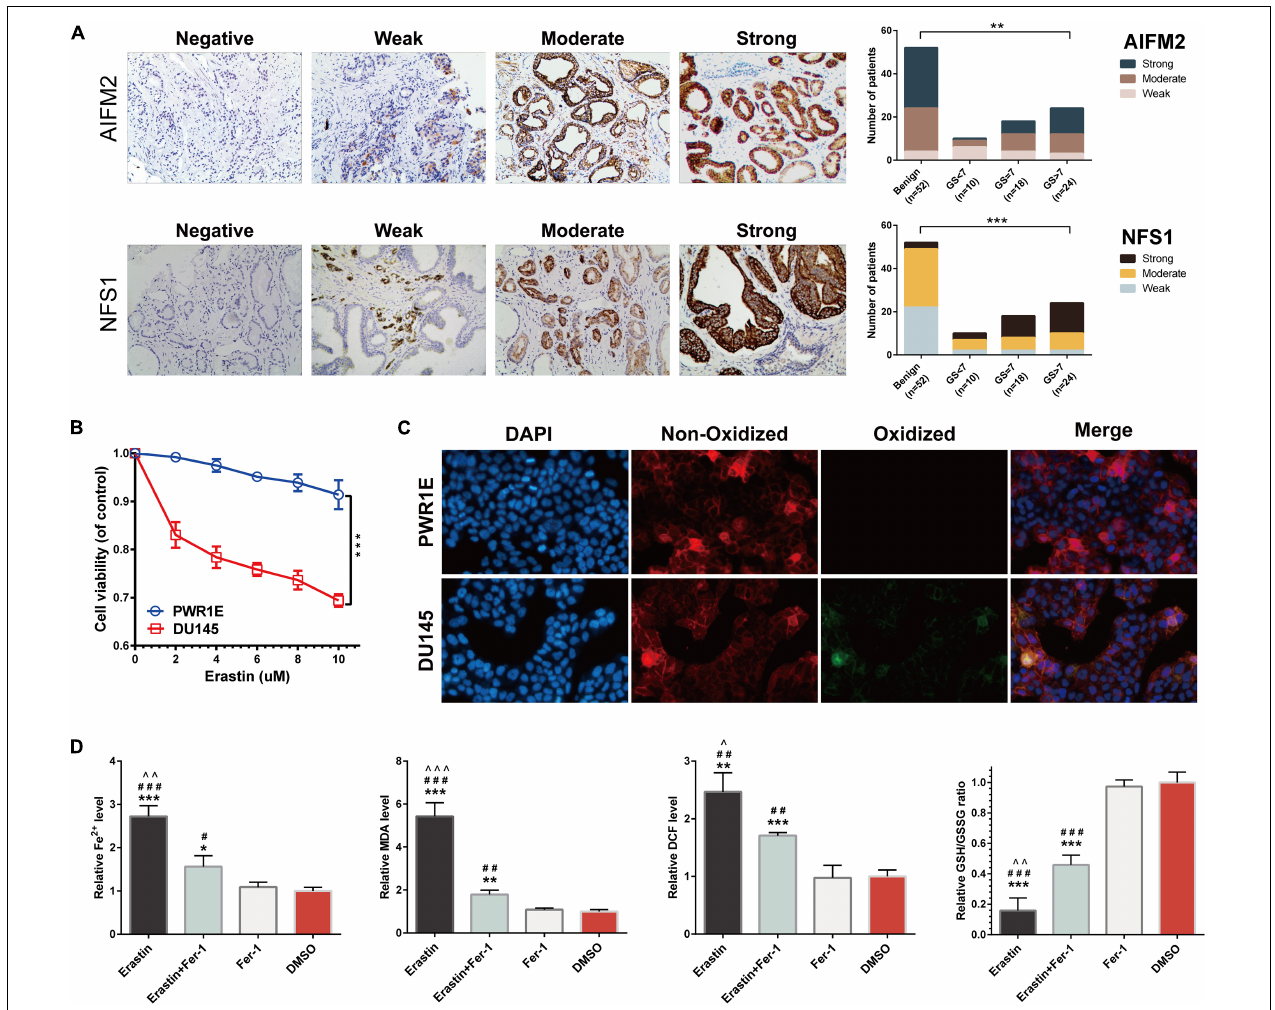
FIGURE 12 | Immunohistochemistry (IHC) verification of AIFM2 and NFS1 and sensitivity verification of PCa cells to ferroptosis. (A) The protein expression of AIFM2 and NFS1 in tumor and normal tissues by IHC. (B) Cell viability was assessed following exposure of DU145 cells and PWR1E cells to different concentrations of erastin. (C) Immunofluorescence staining of oxidized lipid reactive oxygen species (ROS) (green color) and reduced lipid ROS (red color) formation in DU145 and PWR1E cells treated with erastin for 24 h. (D) Fe 2 + release, malondialdehyde (MDA), DCF, and glutathione (GSH) levels detected by Assay Kit in DU145 cells incubated with erastin, ferrostatin-1, both, and DMSO for 24 h (* p < 0.05; ** p < 0.01; *** p < 0.001; # p < 0.05; ## p < 0.01; ### p < 0.001; ∧ p < 0.05; ∧∧ p < 0.01; ∧∧∧ p < 0.001).